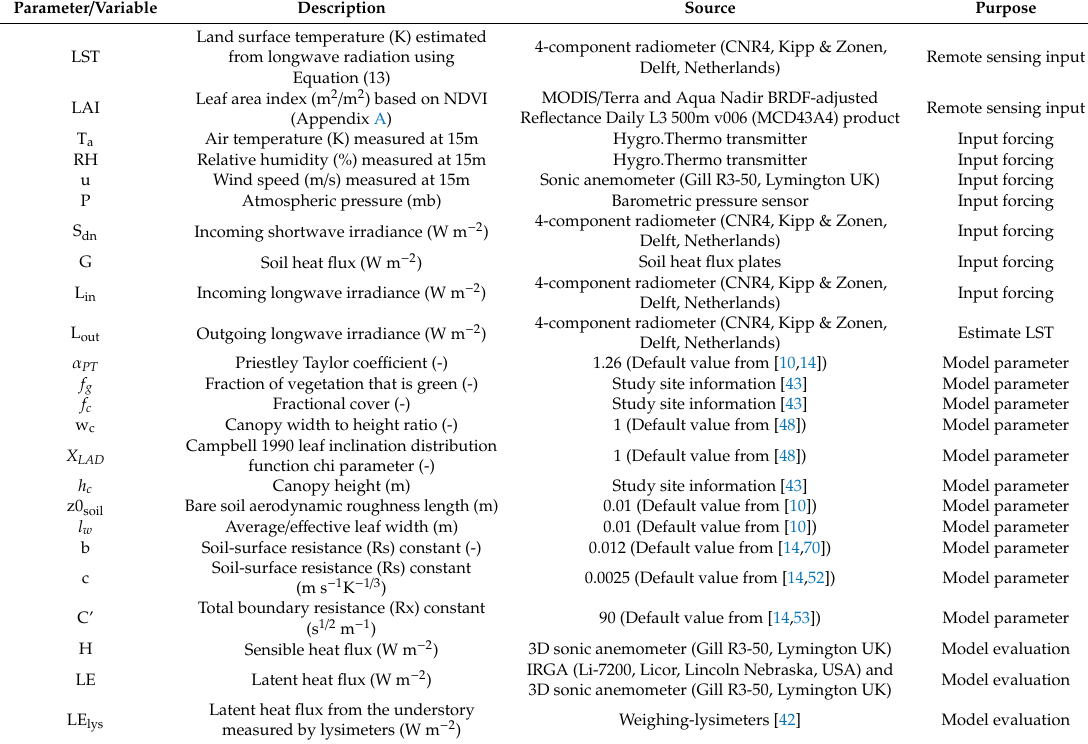
Table 1. Data used to parameterize and evaluate the TSEB